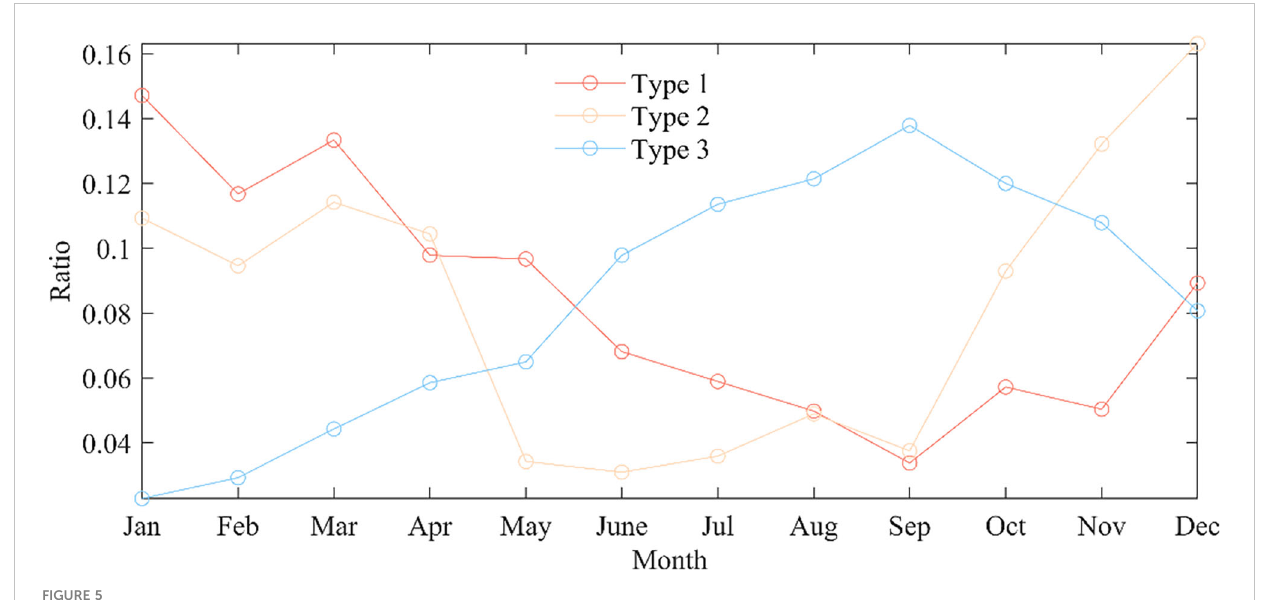
FIGURE 5 Seasonal distribution of sample